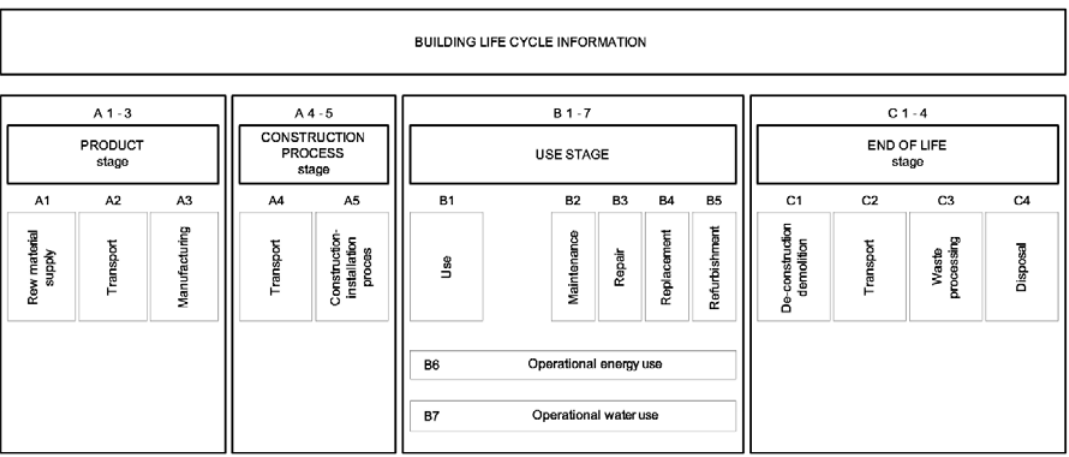
Figure 1. Building life cycle phases according to “Sustainability of construction works–Assessment of environmental performance of buildings–Calculation method” [3].